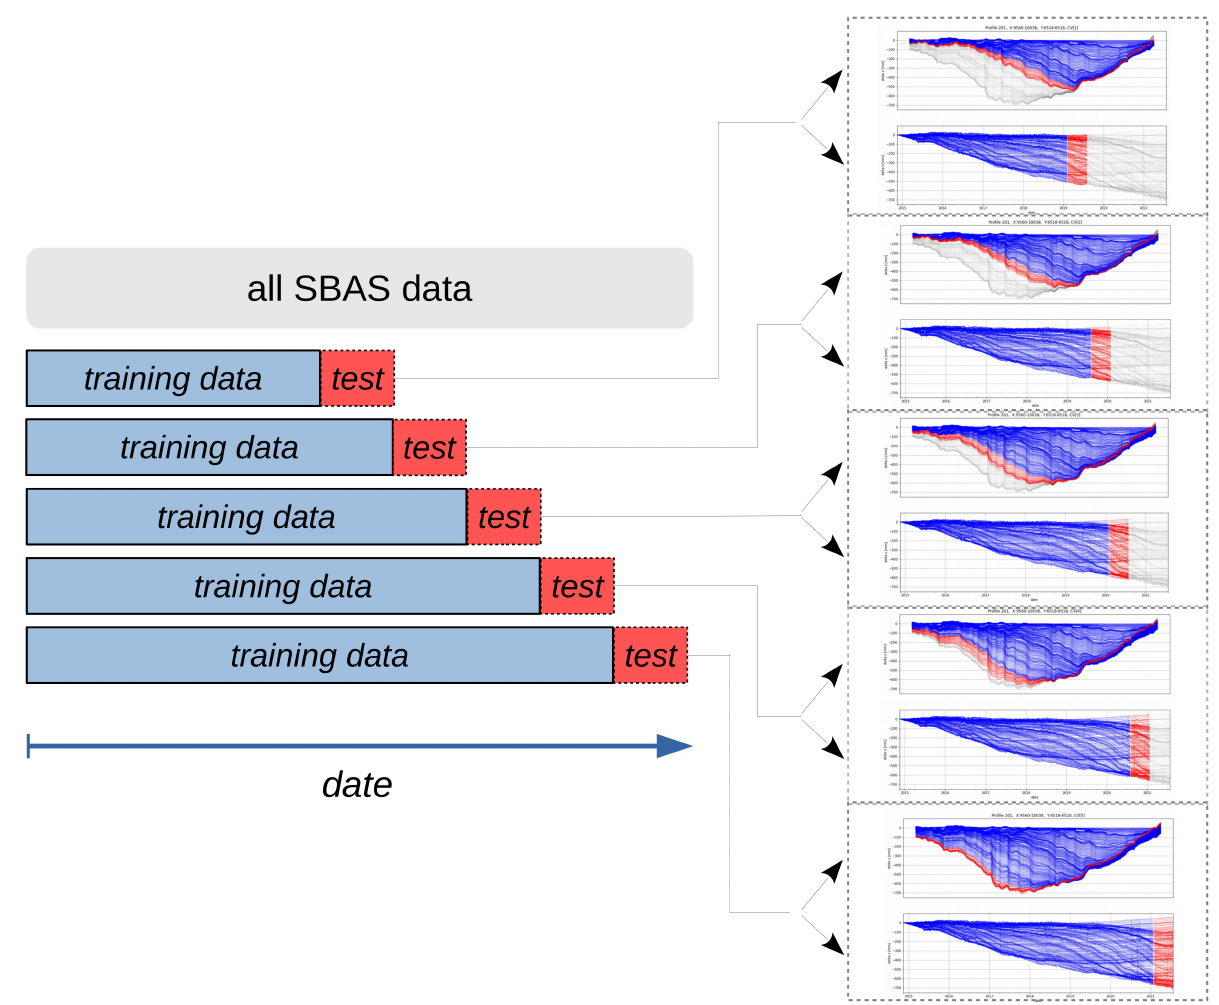
Figure 3. Graphical representation of cross validation used for the analyzed SAR data calculations with the use of the SBAS